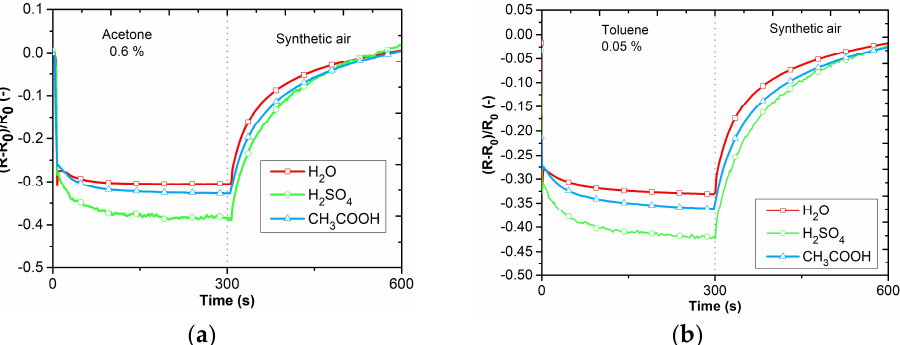
Figure 10. Responses of active layers toward VOCs: ( a ) reaction to acetone, ( b ) reaction to toluene.